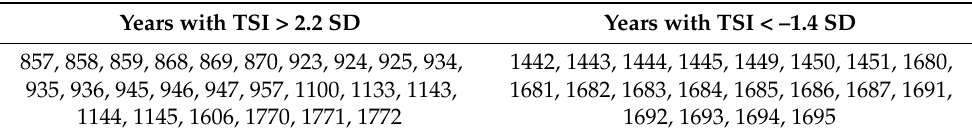
Table 2. Details on the years with TSI anomalies exceeding, by 2.2, the standard deviation value (column 1) and with negative TSI anomalies exceeding 1.4 times the standard deviation value (column 2). Years with TSI > 2.2 SD Years with TSI < –1.4 SD 857, 858, 859, 868, 869, 870, 923, 924, 925,